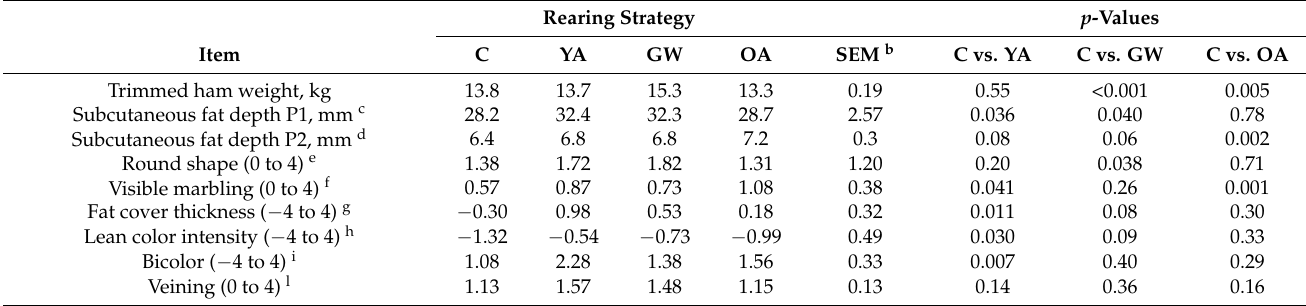
Table 6. Green and trimmed ham characteristics of heavy pigs raised according to the traditional rearing system (control, C), and three alternative strategies (younger age, YA; greater weight, GW; and older age, OA) a